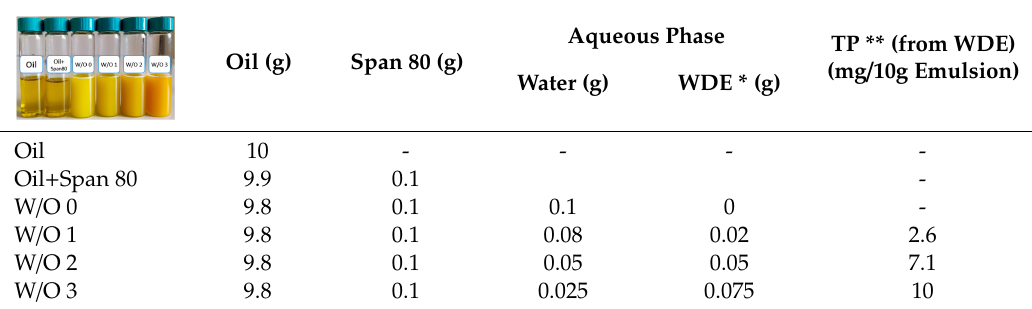
Table 2. Samples aspects and composition. Oil and oil + Span 80 are treated with an Ultra-turrax in order to supply them the same energy as the emulsion